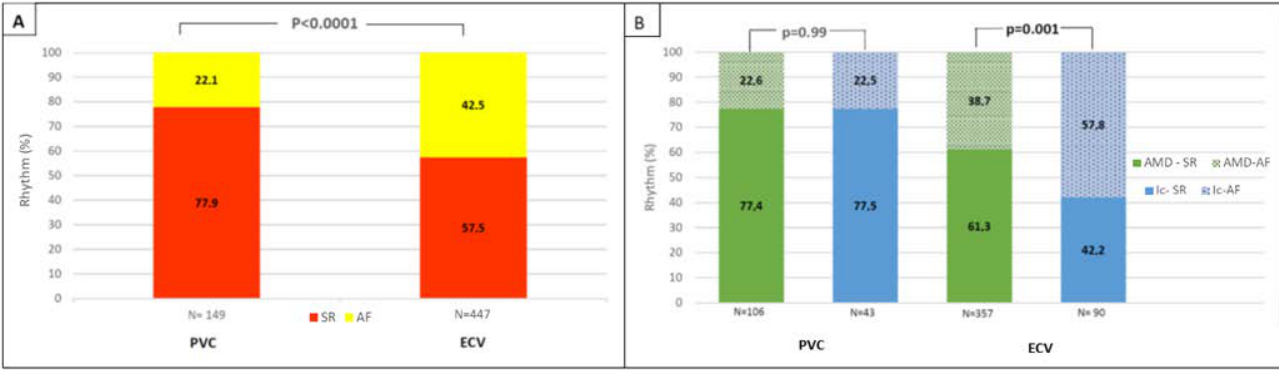
Figure 2. ( A ): Maintenance in sinus rhythm at 3 months according to cardioversion mode. ( B ): Maintenance of sinus rhythm at 3 months according to the antarrhythmic drug used. ECV, electrical cardioversion; PCV, pharmacological cardioversion; AMD, amiodarone; AF: atrial fibrillation; SR, sinus rhythm.